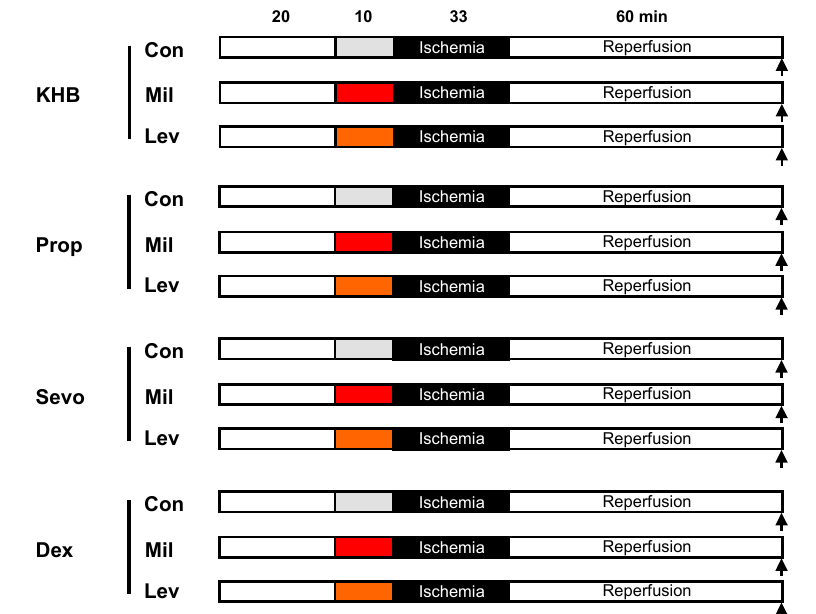
Figure 1. Experimental protocol. KHB, Krebs–Henseleit buffer; Prop, propofol; Sevo, sevoflurane; Dex, dexmedetomidine; Con, control; Mil, milrinone preconditioning (red); Lev, levosimendan preconditioning (orange).